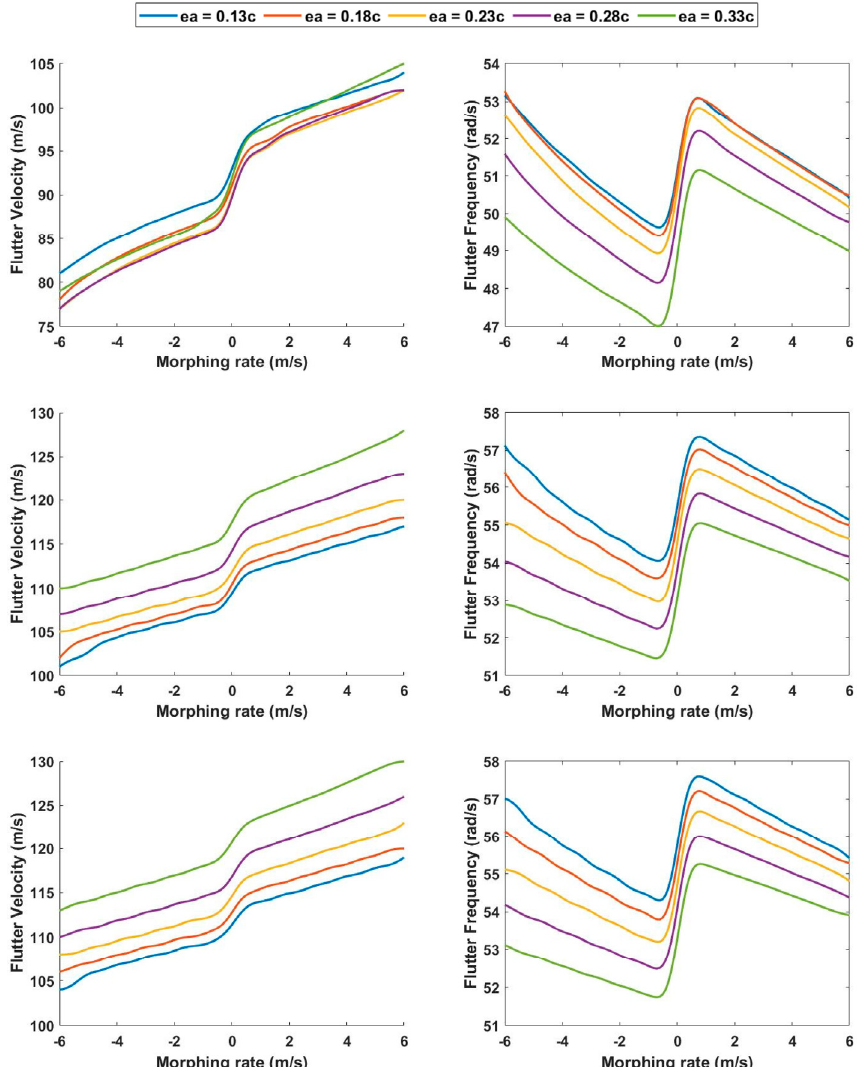
Figure 10. Left: Flutter Velocity vs. morphing rate for span of 7.605 m. Right: Left: Flutter Frequency vs. morphing rate for span of 7.61 m. Top : GJ = 1% of baseline wing. Middle : GJ = 10% of baseline wing. Bottom : GJ = 100% of baseline wing.